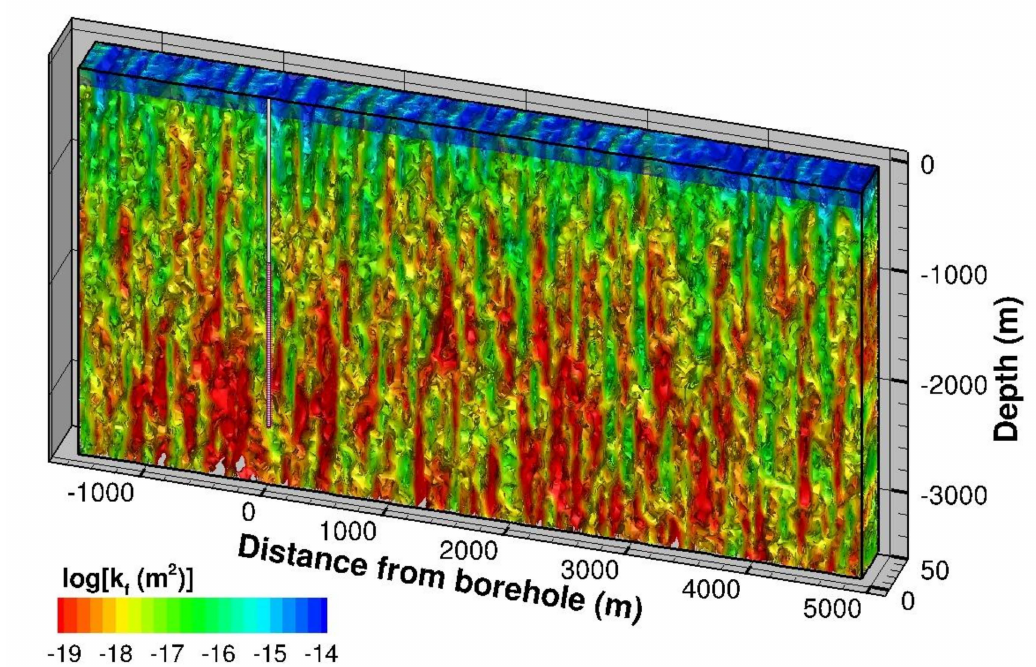
Figure 3. Three-dimensional distribution of depth-dependent, random, spatially correlated permeabilities of fracture continuum below a 200 m thick aquifer. Y -axis and borehole diameter exaggerated by a factor of